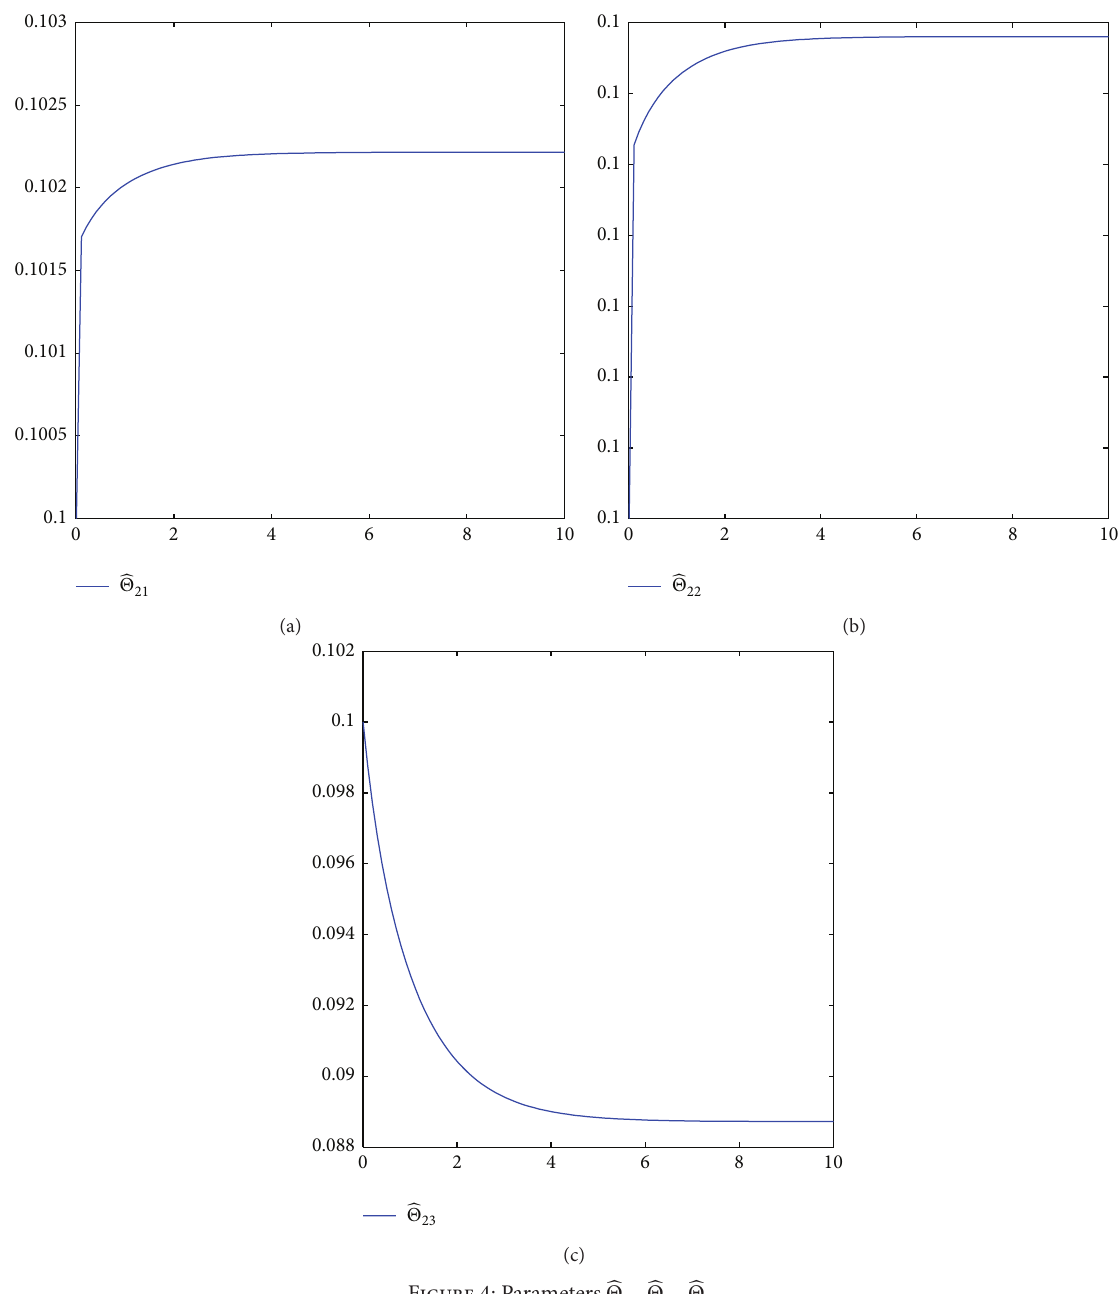
Figure 4: Parameters